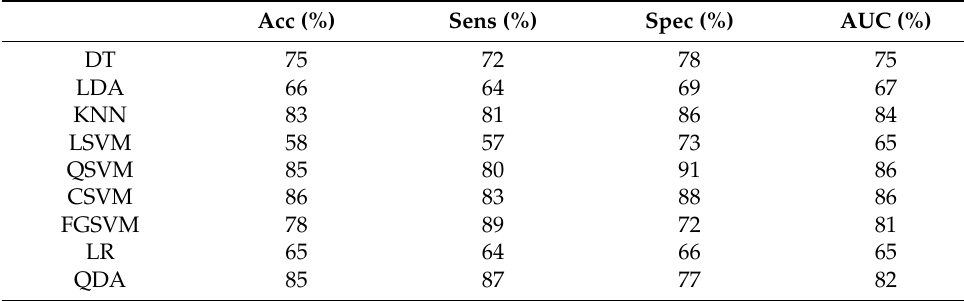
Table 8. Results for the LSDL for Dataset